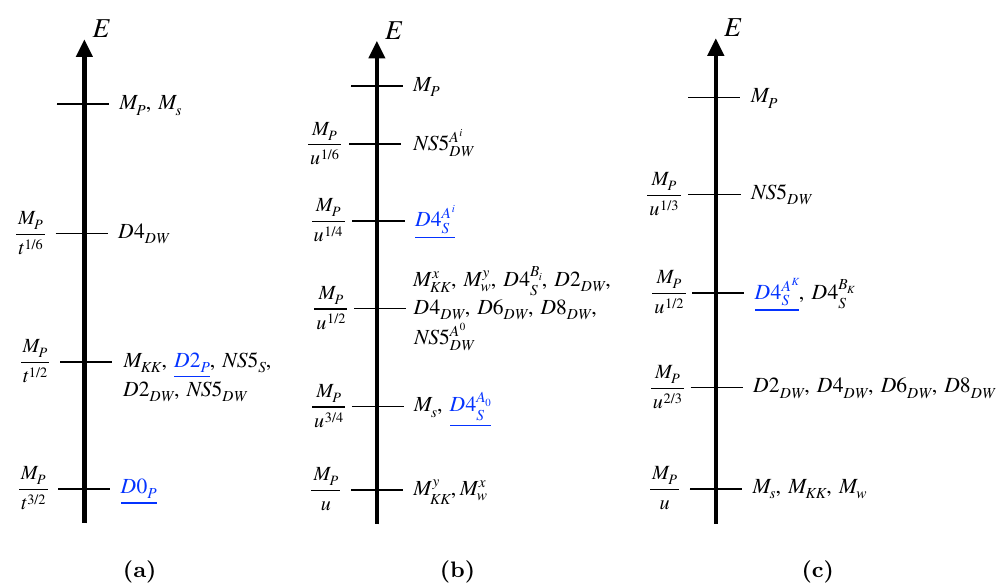
Figure 3. Energy scales associated to the 4d particles, strings and domain walls that become massless/tensionless as we approach the in(cid:12)nite distance points given by (a) t ! 1 ; s; u (cid:12)xed, (b) u ! 1 ; s and t (cid:12)xed and (c) s / u ! 1 ; t (cid:12)xed. The string, KK and winding scales are also included. The subindices P , S and DW indicate whether the object is a particle, a string or a domain wall and the ones in blue and underlined are projected out by the orientifold